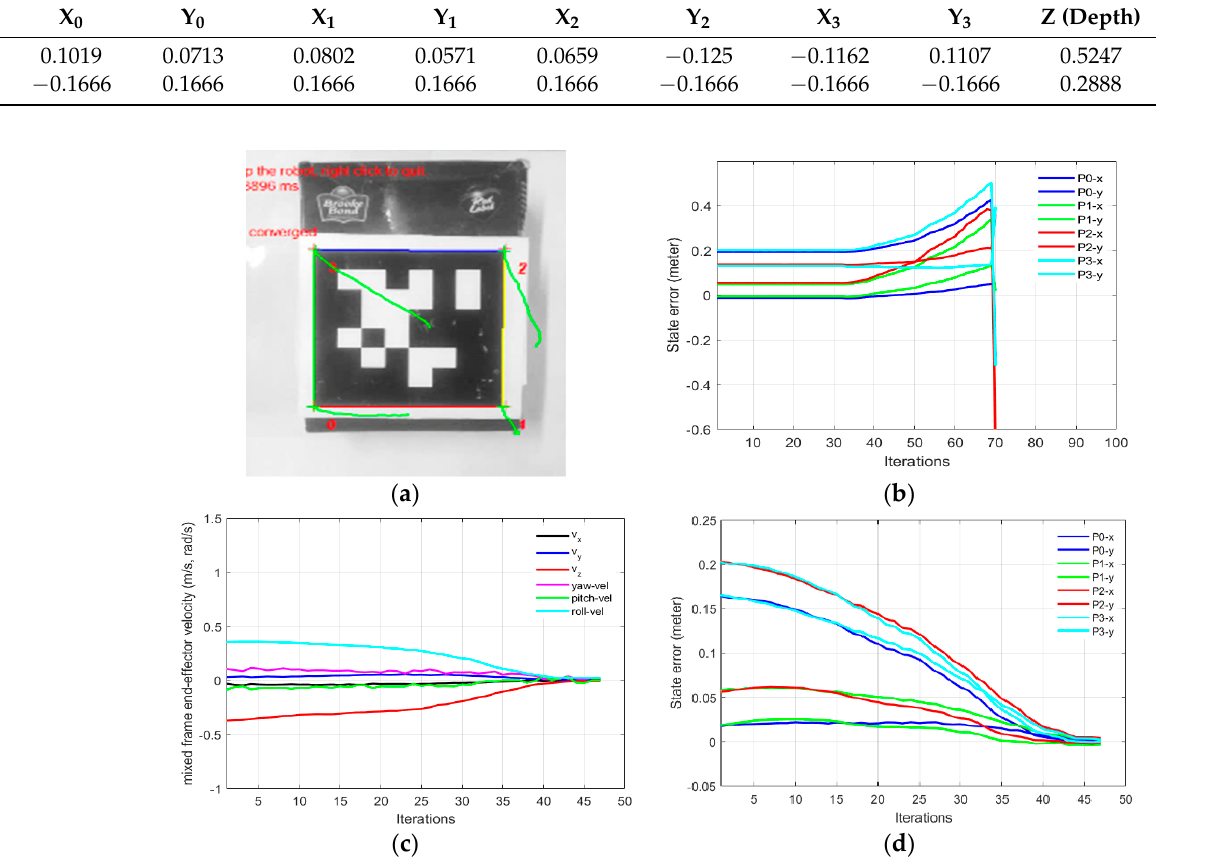
Figure 9. Need for the mix frame visual servo control framework ( a ) feature trajectory for mixed frame velocity ( b ) features error diverging for the end-effector frame ( c ) mixed frame end-effector velocity ( d ) feature error decay for mix frame control.